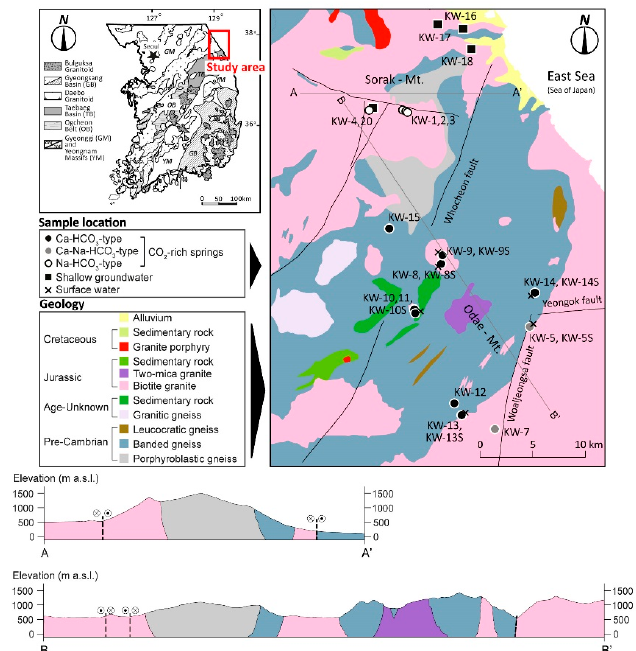
Figure 1. Geological map with cross sections (A-A’ and B-B’) of the northeastern part of Gangwon Province, South Korea, with the locations of CO 2 -rich water (circles), shallow groundwater (squares) and surface water (crosses) (modified after Choi et al. [25]). The water types were classified based on the Piper diagram (see below).